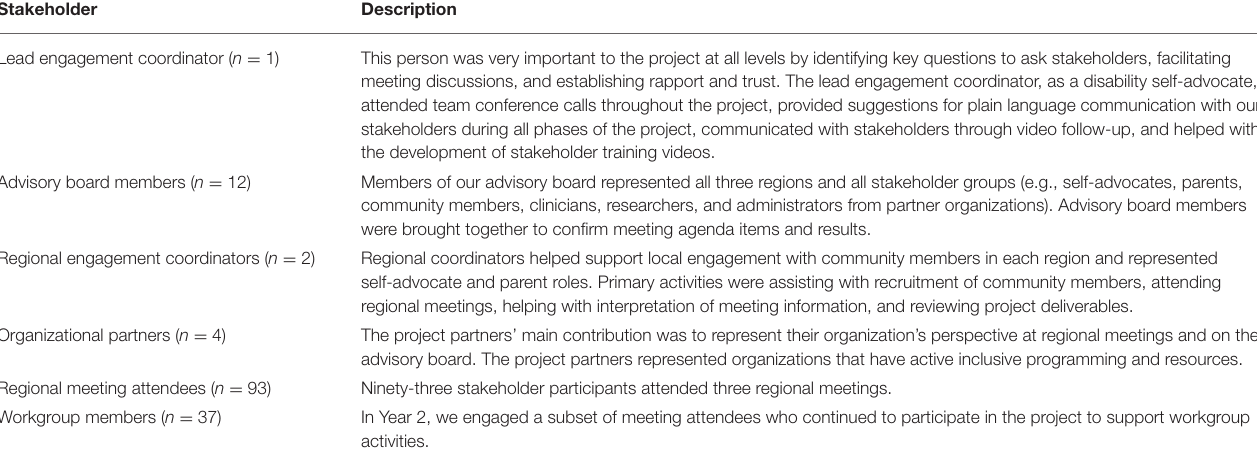
TABLE 2 | Key stakeholder roles.